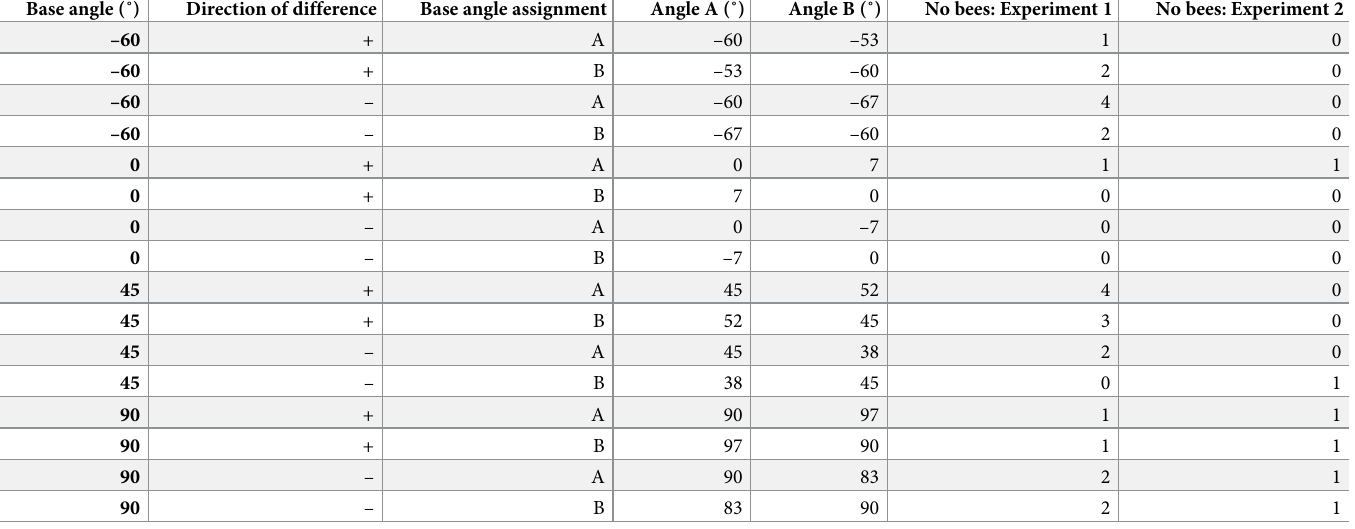
Table 1. Number of bees tested with each pair of bar angles in experiments 1 and